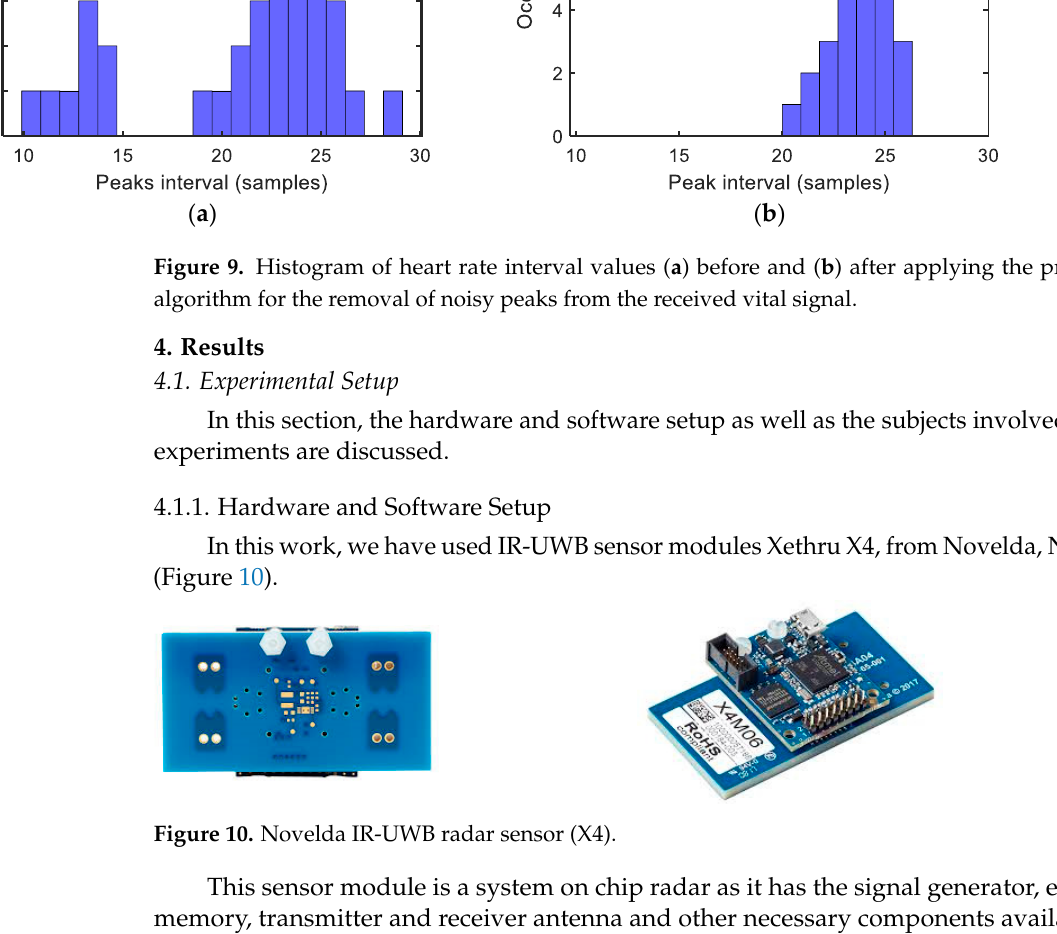
Table 1. Radar module parameters. Parameters